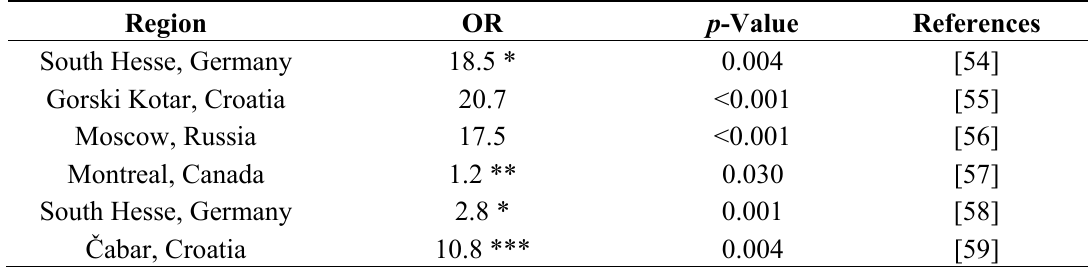
Table 2. Case-control studies of processed meats in the MS generation. Region OR p -Value